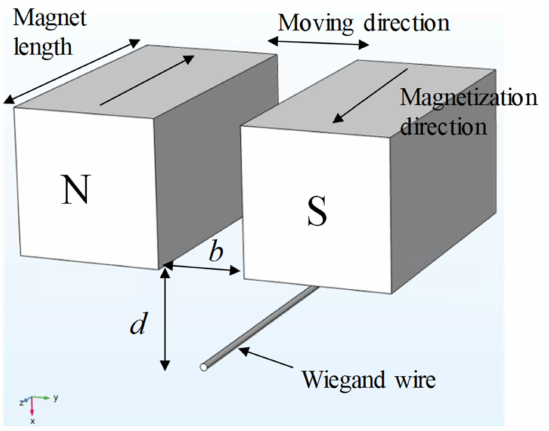
Figure 4. Magnetic circuit design and definitions.